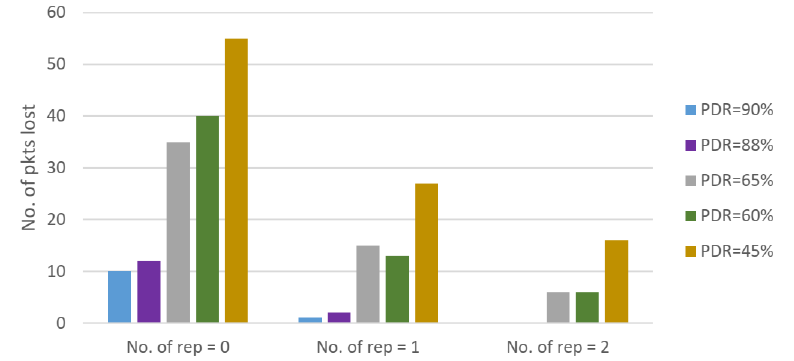
Figure 15. Effect of repetition on packet